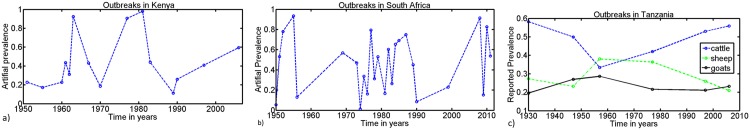
Temporal history of RVF outbreaks in some countries of Sub-Saharan Africa.In (a) and (b) the circles represent years of outbreaks occurrence in Kenya and South Africa [3, 9] and the prevalence indicated in the figure is not real, it is just for representation only since data on prevalence is not available. In (c) the circles represent the prevalence of disease outbreaks in Tanzania [7].